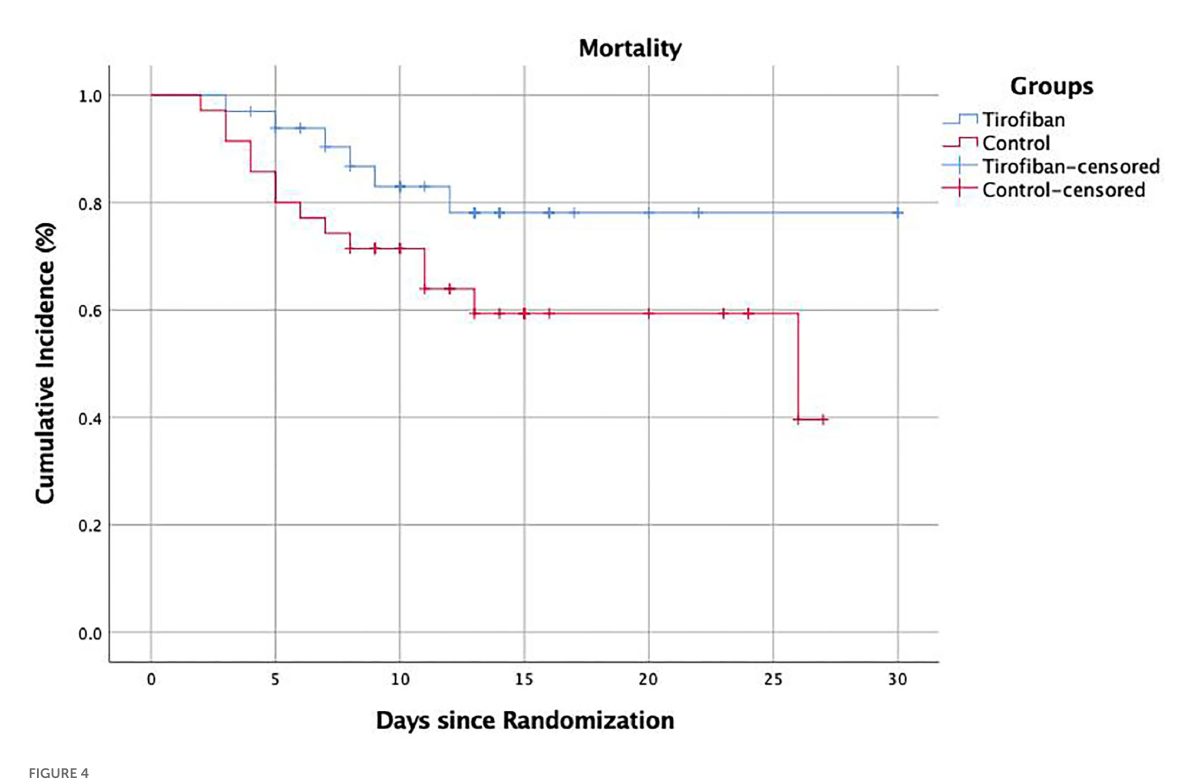
FIGURE4 Cumulative mortality in